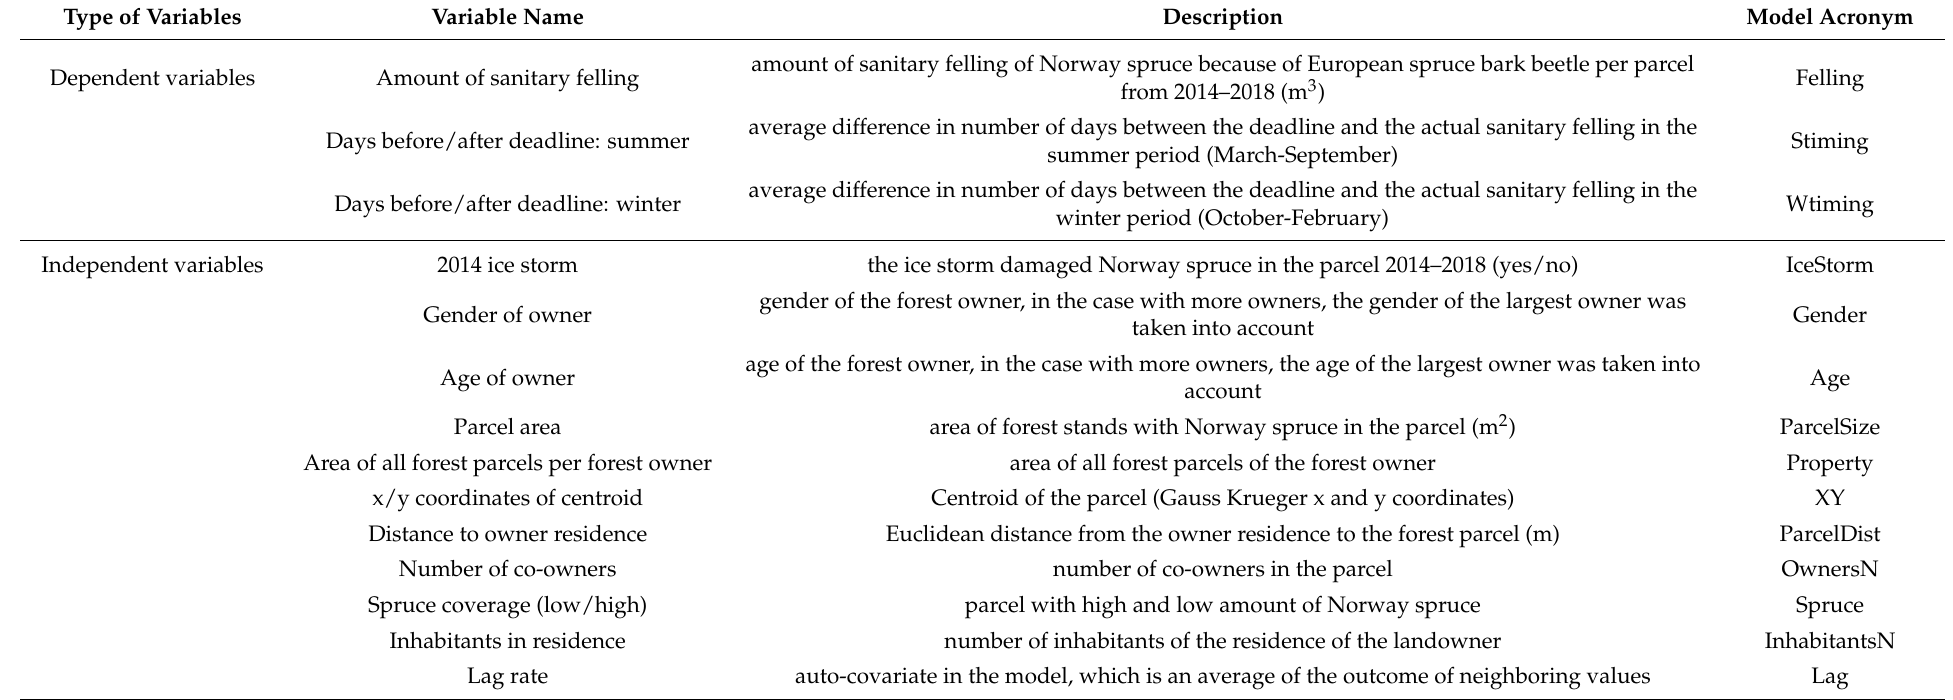
Table 1. Description of the variables used in the models for the sanitary felling and timing of the sanitary